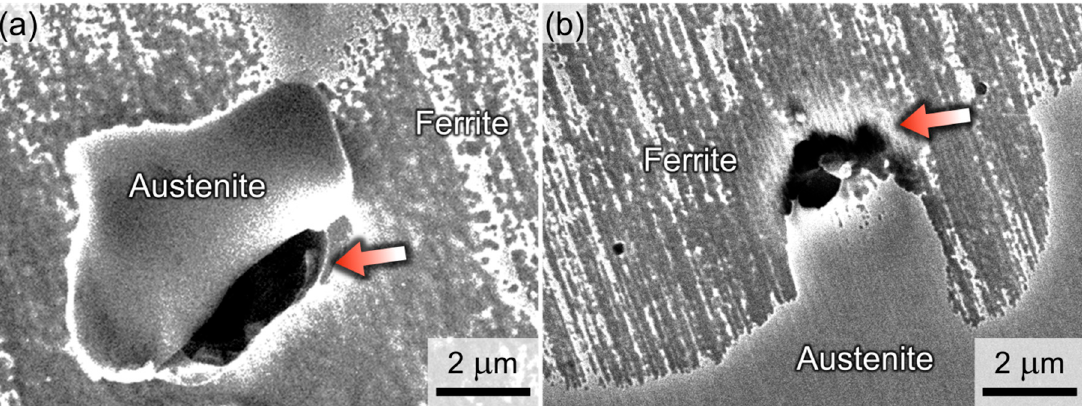
Figure 9. Pit morphologies of ( a ) DSS-N and ( b ) DSS-NC after immersion in a 0.2M HCl solution at 25 °C for 4 h.